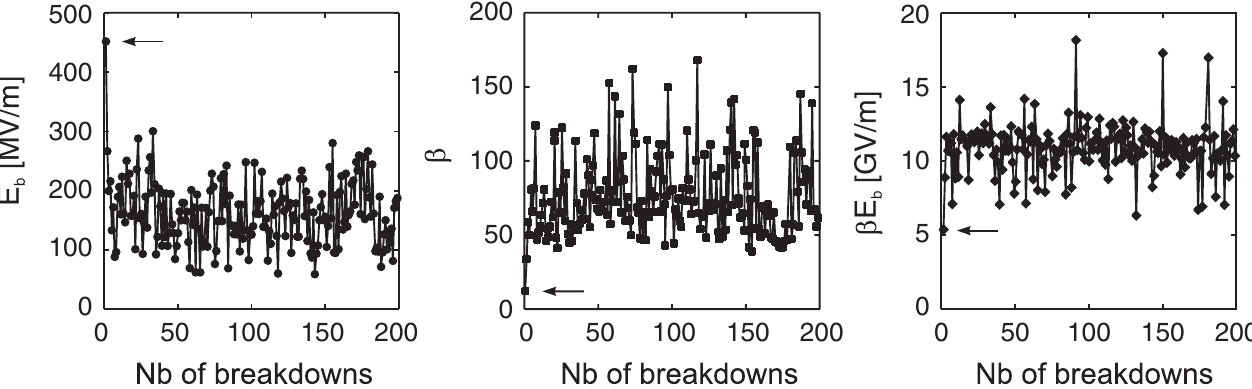
FIG. 4. Evolution of E b , (cid:1) and local breakdown field during a typical conditioning experiment with Cu electrodes. Arrows indicate values of the first